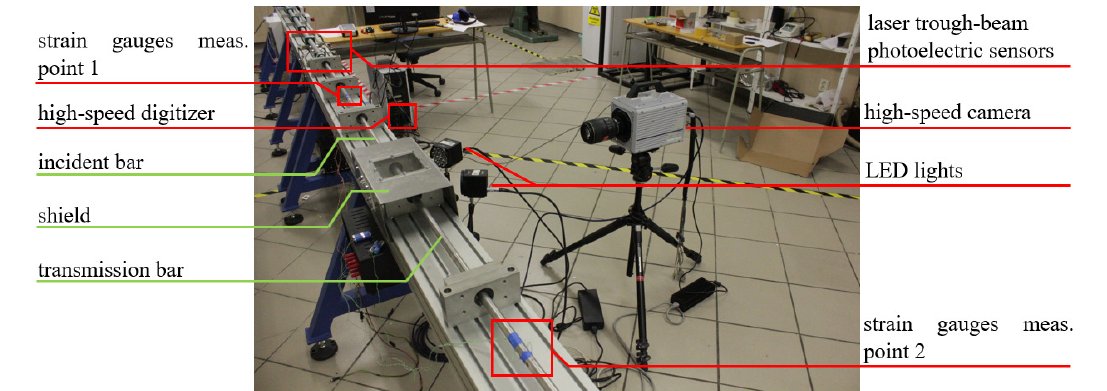
Figure 3. SHPB experimental setup